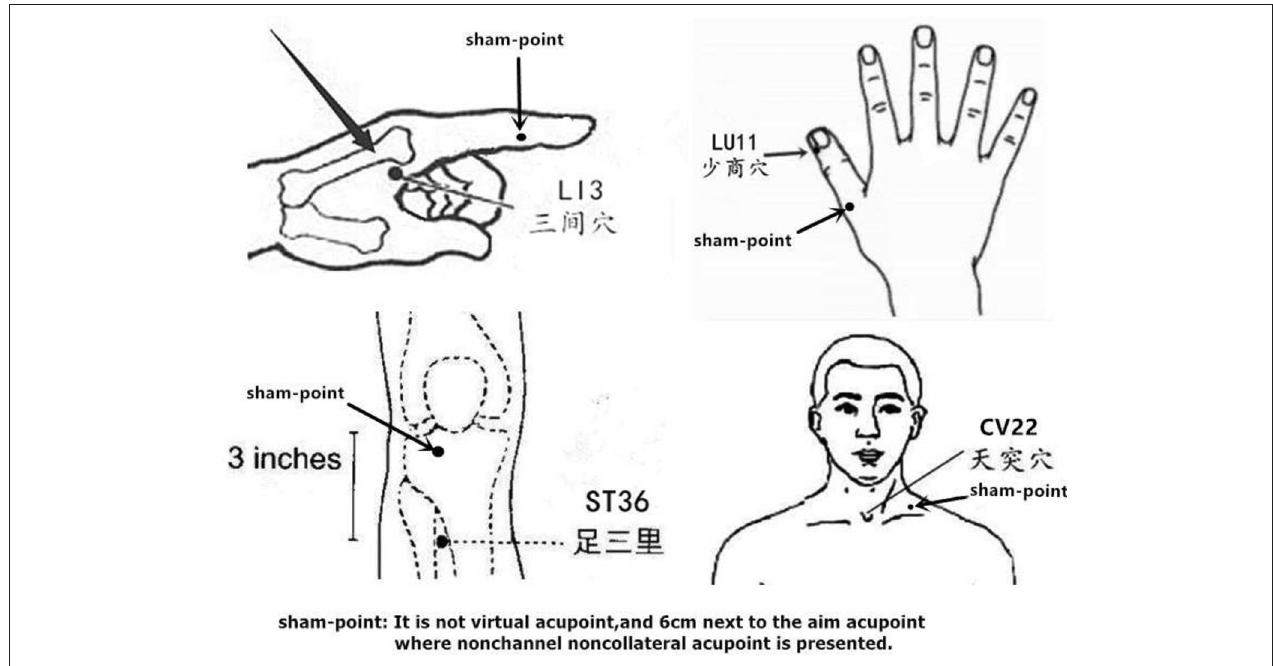
FIGURE 1 | Location of